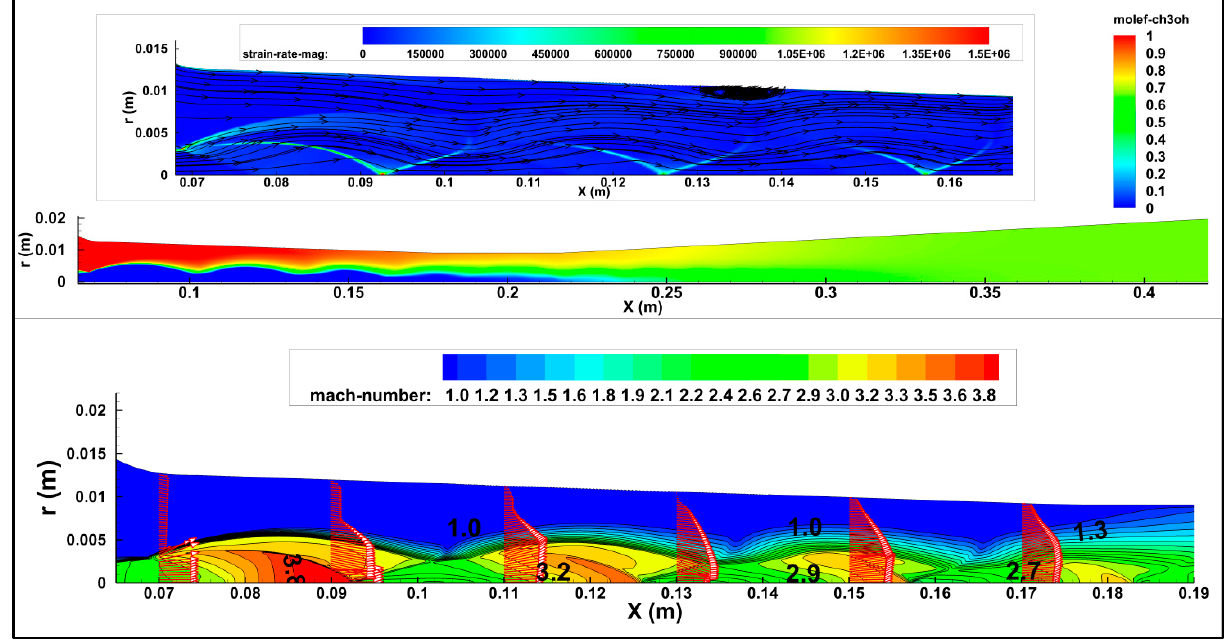
Figure 3. Flow dynamics inside the ejector at a compression ratio of 2.26 for the CF2I2-CH3OH fluid pair.